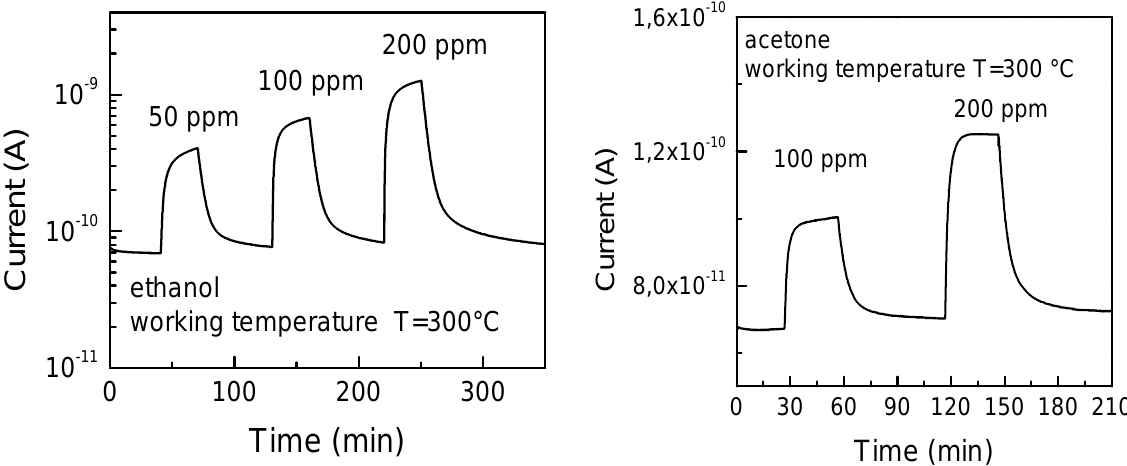
Figure 12. Typical dynamic response of the MAPLE deposited TiO different concentrations of ethanol (right) and acetone (left) vapors at the working temperature of 300 °C.